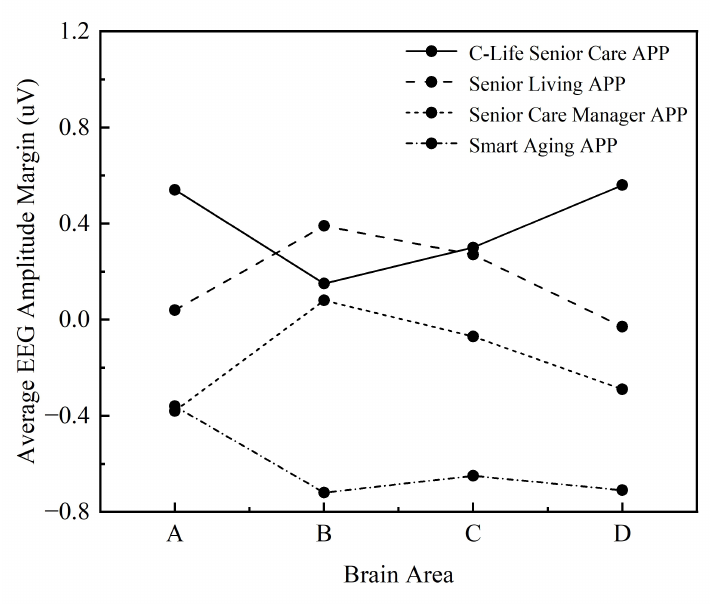
Figure 10. Marginal mean of brain area amplitudes: A refers to Frontal area; B refers to Parietal area; C refers to Temporal area; D refers to Occipital